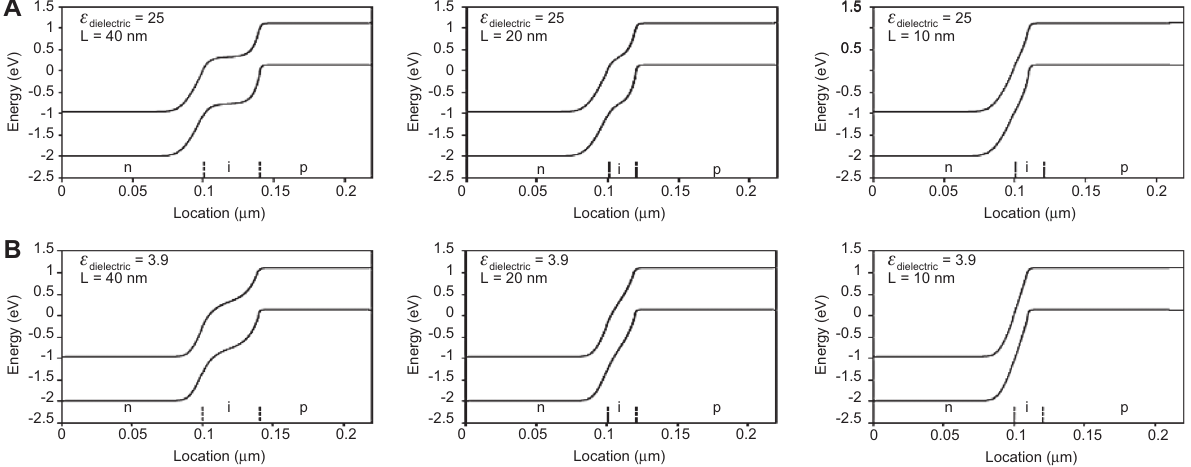
Figure 14 Schematic band diagrams of TFETs with different gate dielectrics, (A) ε = 25 and (B) ε = 3.9; there is no interfacial oxide layer within the high- κ gate dielectric stacks. With a channel length of 40 nm, both devices are effectively turned off and the depletion region was well defined. When the channel length was reduced to 20 nm, the TFET using low gate dielectric ( ε = 3.9) begins to break down. At channel length of 10 nm, the devices break down in both cases with a tunneling width less than 10 nm. Reprinted from Ref. [16], with permission, from